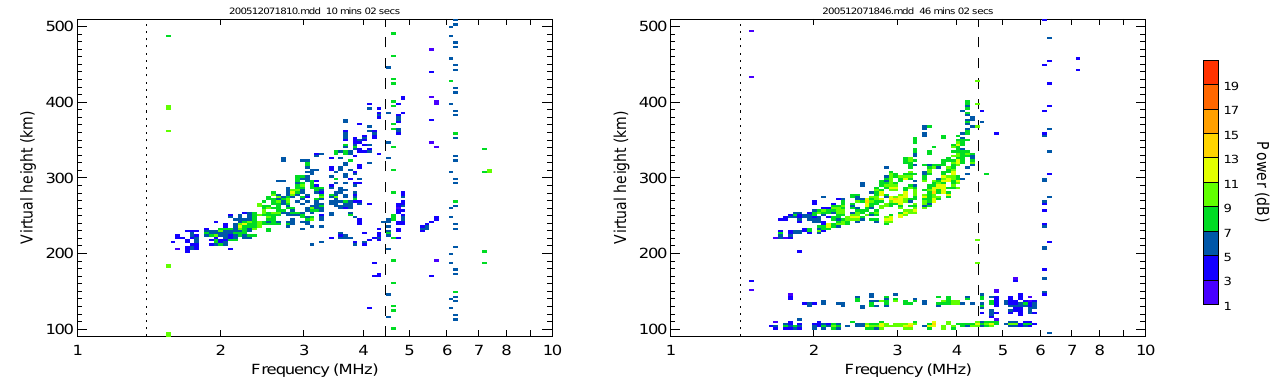
Fig. 1. Ionograms taken at 18:10 and 18:46UT on 7 December 2005 (interval 1). The ionogram from 18:46UT has signatures consistent with a porous sporadic E-layer that affects waves with frequencies from 2–6MHz. There is also evidence of second-hop scatter over this frequency range. These ionograms, together with those shown in Figs. 2 and 3, were recorded using the Svalbard ionosonde during dropouts when SPEAR was not transmitting. In these figures, the SPEAR frequency of 4.45MHz is denoted using a vertical dashed line.